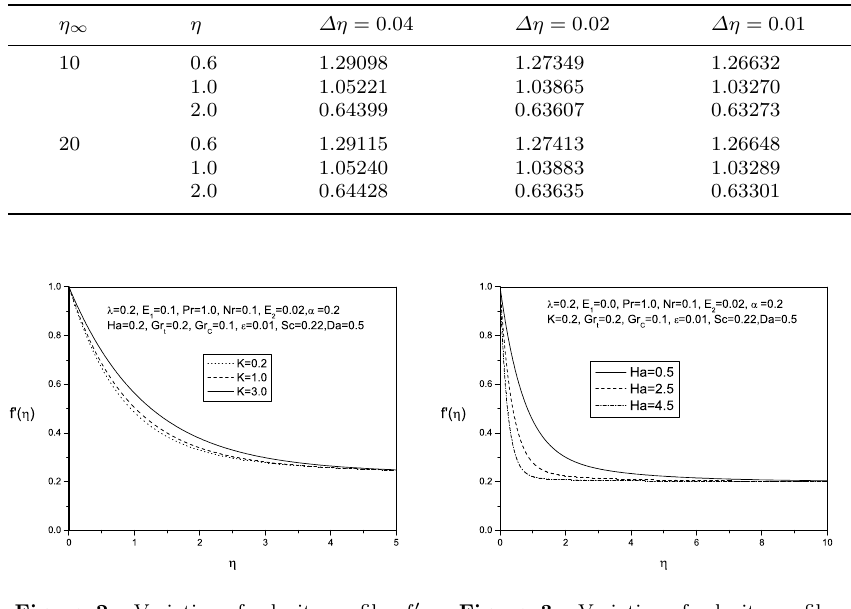
Figure 2. Variation of velocity profiles f (cid:48) with η for different values of K .